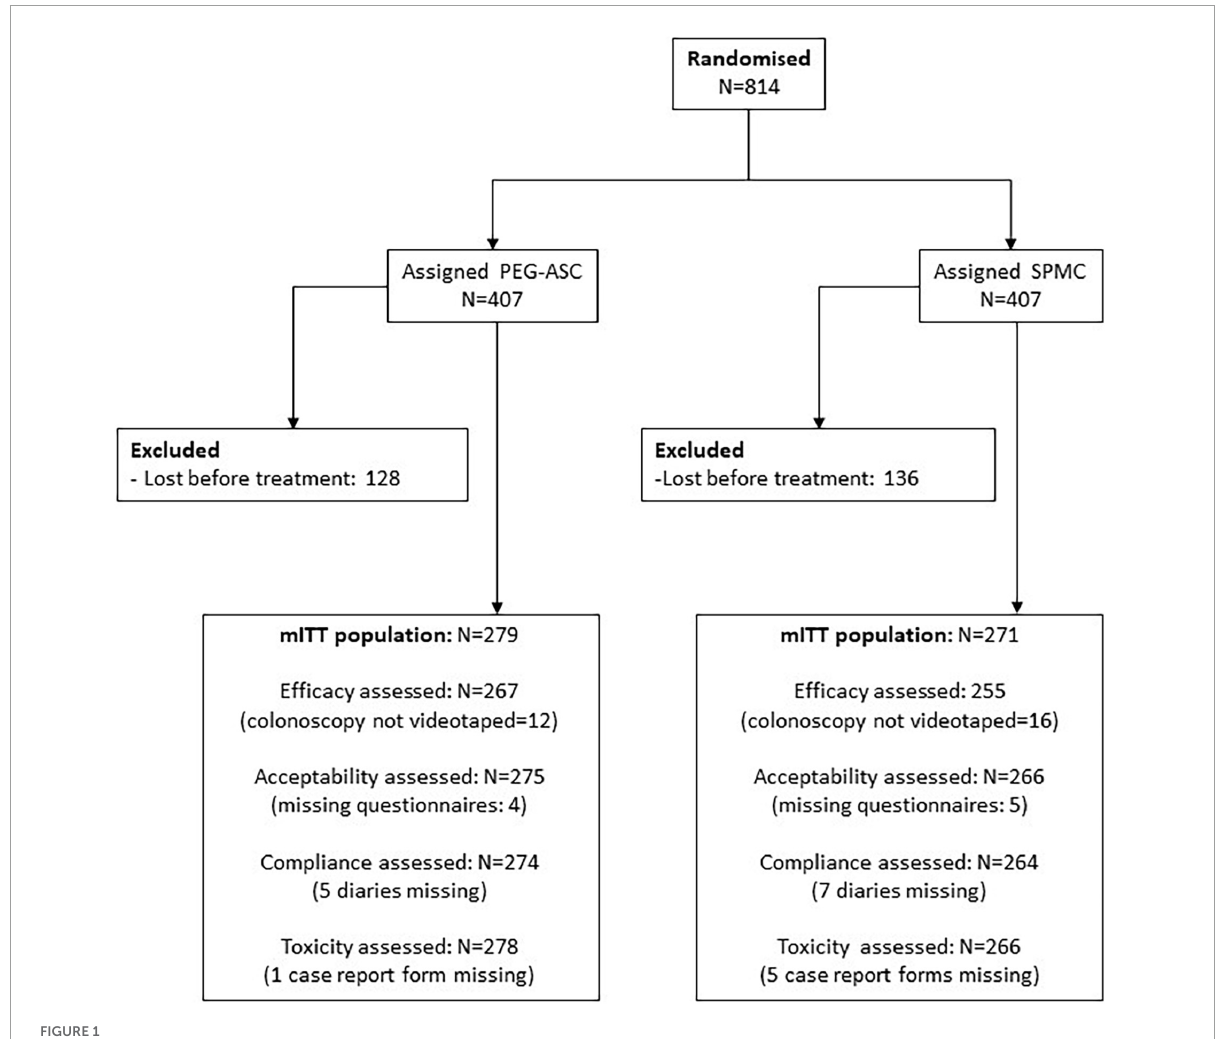
FIGURE1 Patients